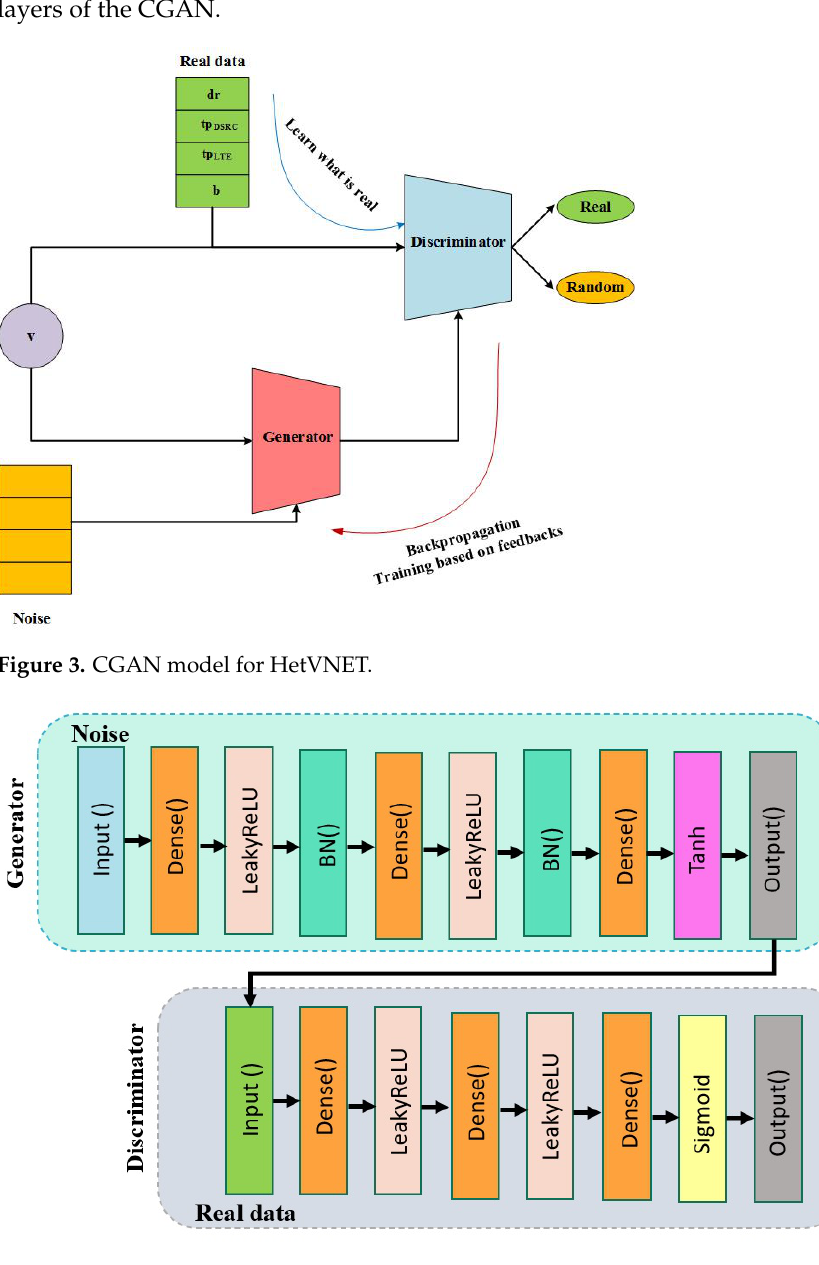
Figure 4. The architecture of the proposed CGAN that shows generator’s layers and discrimina- tor’s